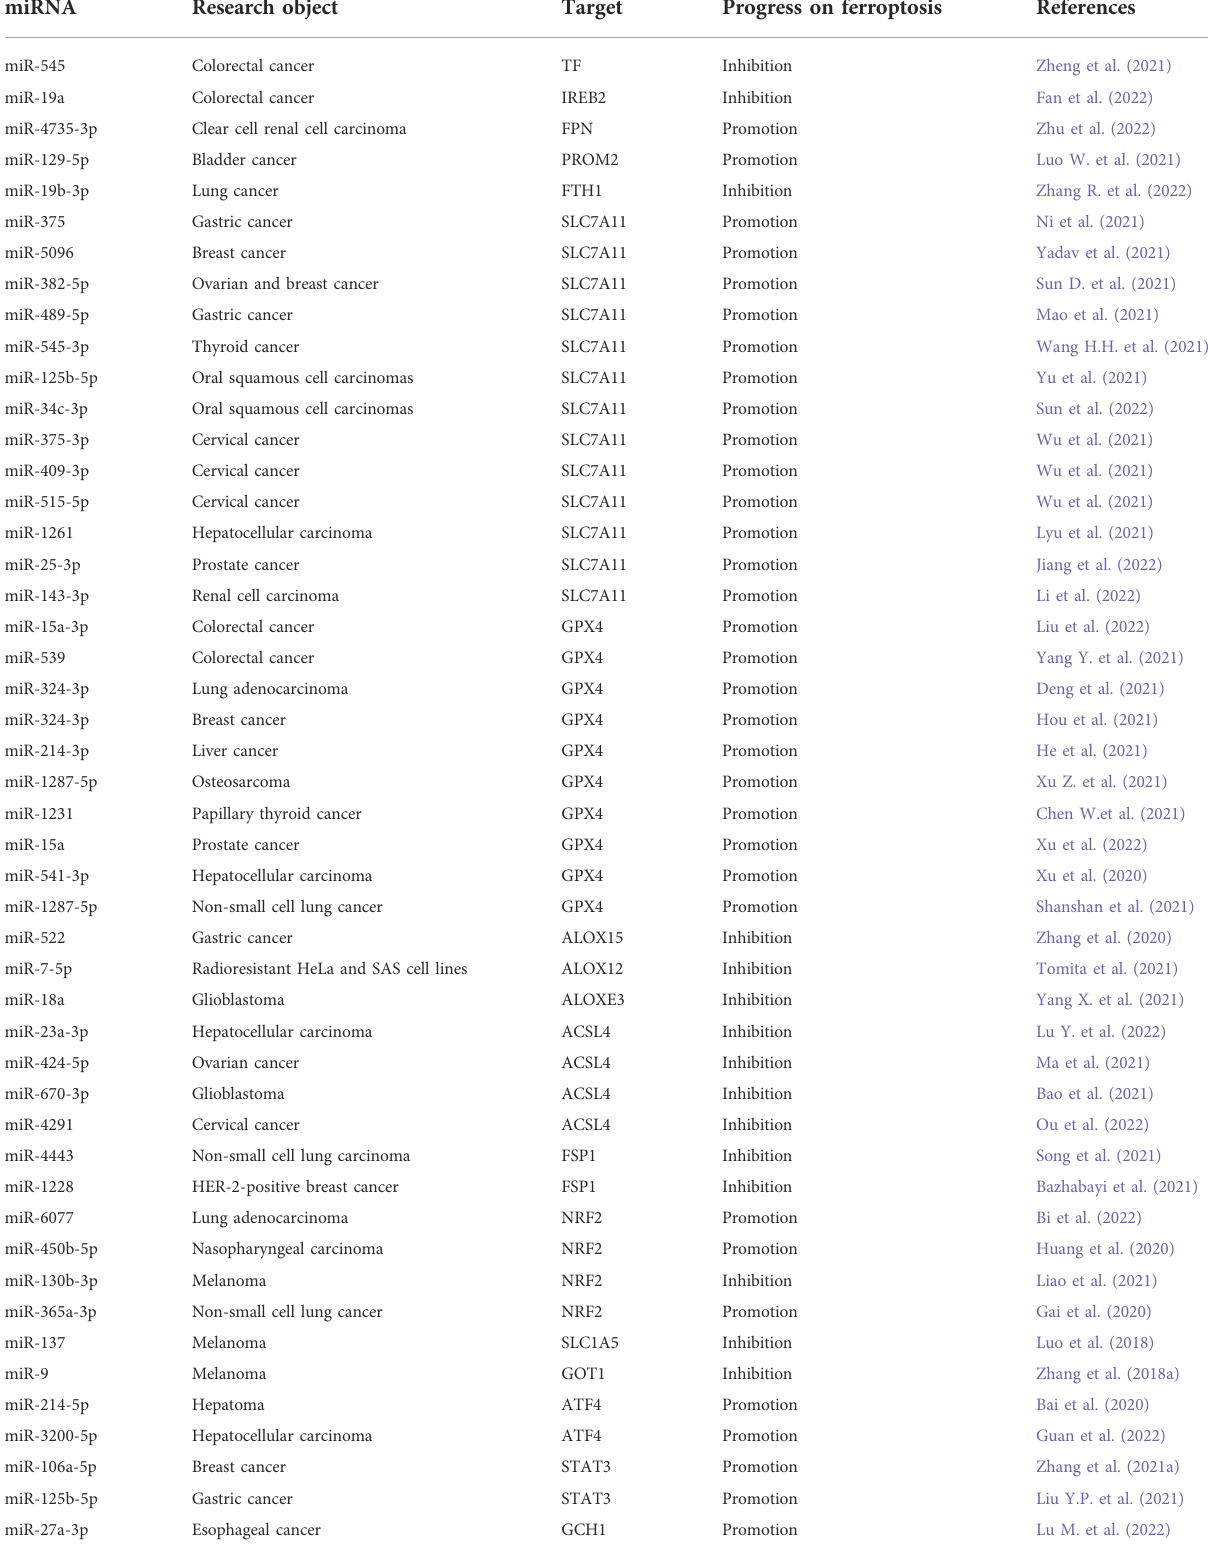
TABLE 1 The basic information of miRNA in ferroptosis signaling